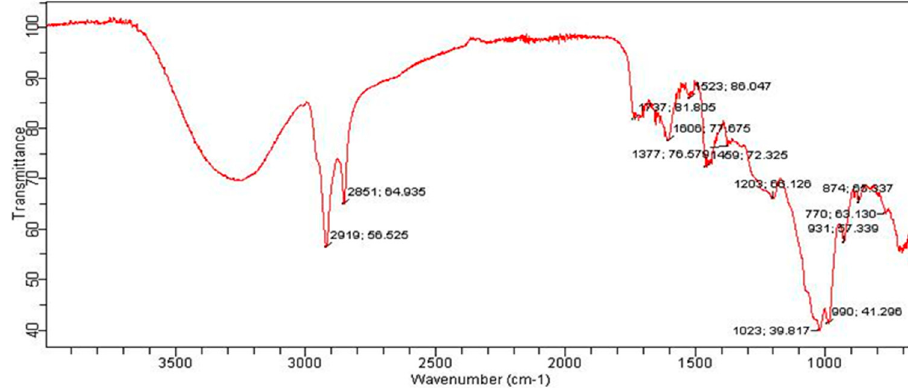
Figure 4. FTIR spectrum of MBC.